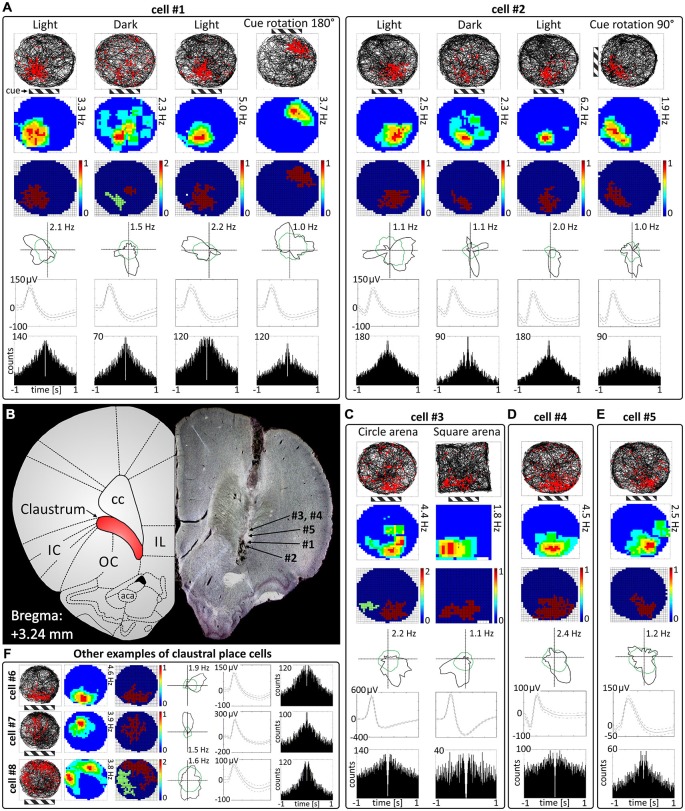
Place cells in rat anterior claustrum. (A) Examples of two spatially-tuned claustral cells recorded over consecutive sessions with changes in environmental conditions. Each cell was recorded in the light, darkness, light and after rotation of visual cue in the light. The pattern of response suggests that activity of claustral place cells is anchored to visual cues (the location of main cue—cue card with black and white stripes is marked on the figure by striped rectangle). For each recording session the following are presented in columns: path of the animal recorded during 20-min session with superimposed firing activity of the unit; firing intensity map with a maximum firing frequency; place map; polar plot; spike waveform and autocorrelation ±1000 ms (those parameters are presented in similar layout in C–E). (B) Estimated locations of spatially-tuned cells presented in this figure reconstructed on histological specimen. On the left side of the histological slide, a schematic anatomical figure with borderlines between structures for similar antero-posterior coordinates is presented. (C) Claustral place cells form place fields in environments of different geometrical shapes when tested after transitions from a circular to square environments in the light. (D,E) Example of two more place cells recorded in the light. The location of place fields was similar in majority of cells suggesting that their activity may be strongly anchored to the visual and possibly other cues in experimental room. (F) Examples of three place cells with different locations of place fields in the experimental arena. Place fields located in other parts of experimental arena than those formed by cells #1—#6 were less prevalent (like in cells #7 and #8). Cell #7 exhibited both spatial tuning and directional tuning. For each cell in rows are presented: path of the animal with superimposed firing activity, firing intensity map, place map, polar plot, spike waveform and autocorrelation ± 1000 ms. Abbreviations: aca, anterior commissure, anterior part; cc, corpus callosum; IC, insular cortex; IL, infralimbic cortex; OC, orbital cortex.